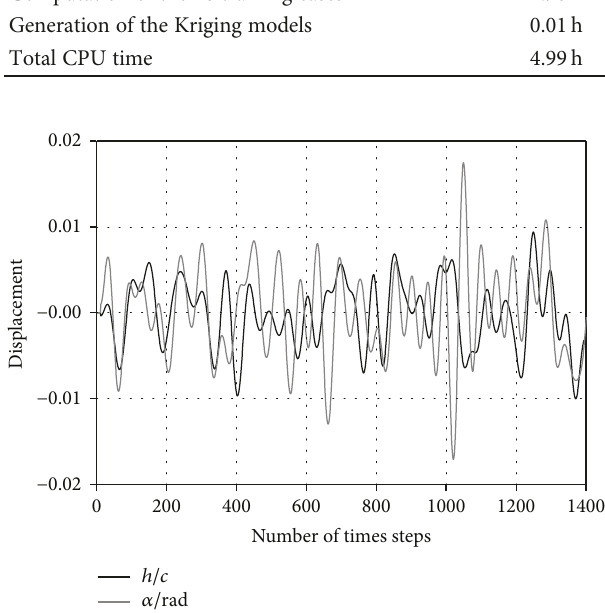
Figure 9: The pitch and plunge motions under the FWGN excitation for ROM validation at M ∞ = 0 76 and α